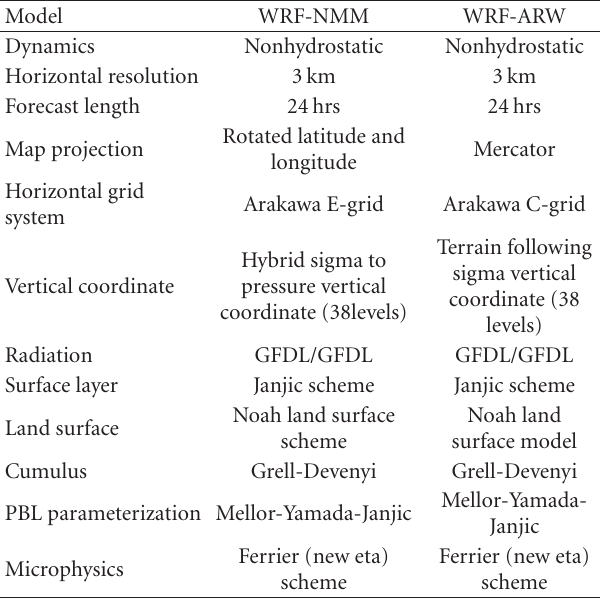
Table 1: ARW and NMM model configuration. Table 2: The di ff erent stability indices and their critical values for severe